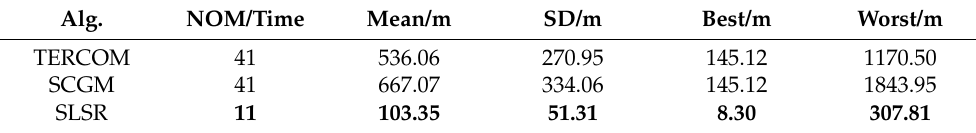
Table 4. Compared matching results of different algorithms for out-of-domain mismatches. Alg. NOM/Time Mean/m SD/m Best/m Worst/m TERCOM 41 SCGM